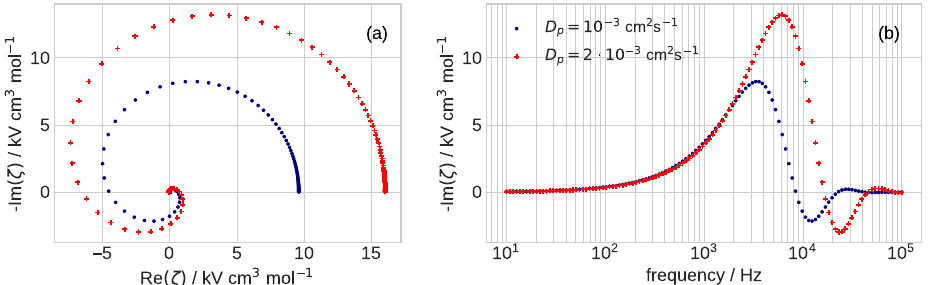
Figure 3. ( a ) The Nyquist spectra and ( b ) the frequency dependence of imaginary part of ζ -impedance, Equation (33), for the indicated values of oxygen diffusion coefficient in the pore D p , cm 2 s − 1 . The other parameters for calculations are listed in Table